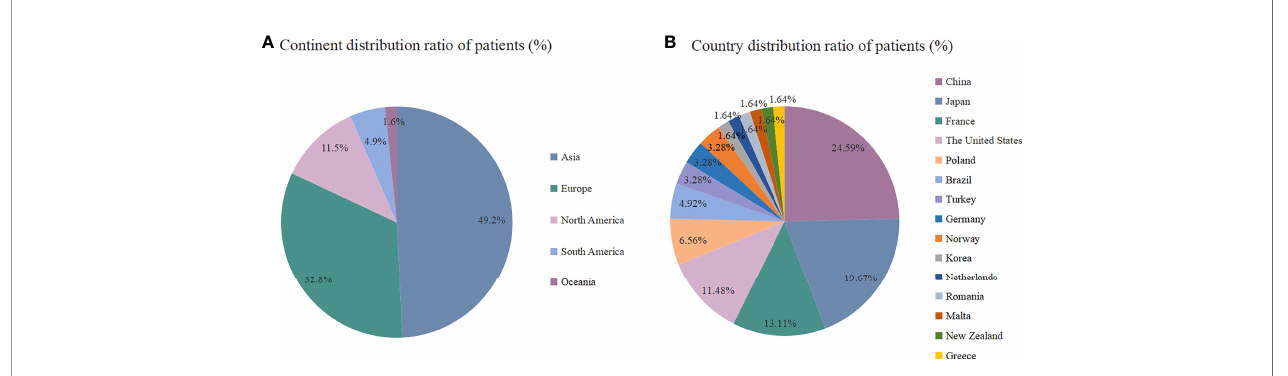
FIGURE 1 | (A) Continent distribution ratio among the patients (%), (B) Country distribution ratio among the